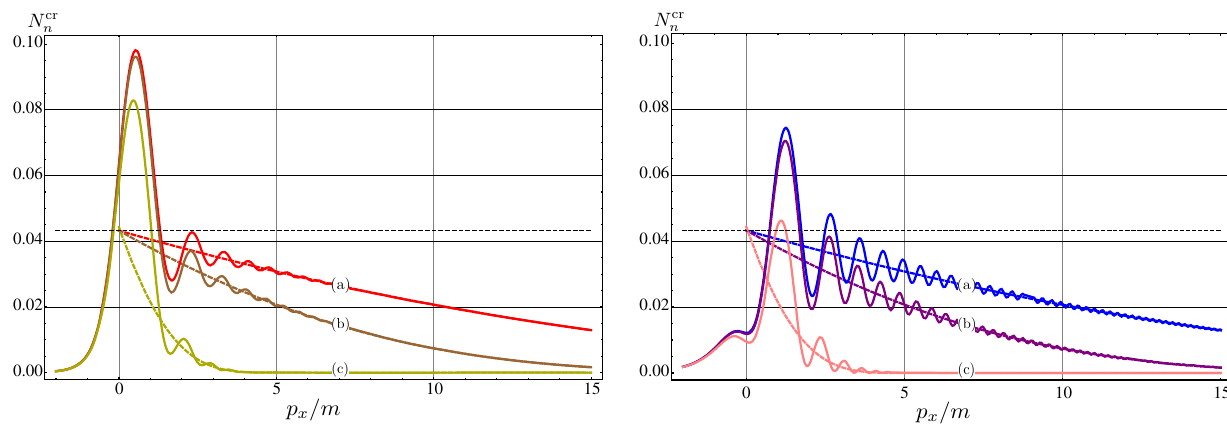
while the asymptotic approximation (47) are represented by dashed lines. The lines labelled with (a), (b) and (c), refers to m τ 2 = 100, 50 and 10, respectively. In both plots, E = E c and the horizontal dashed line denotes the uniform distribution e − πλ which, in this case, is e − π